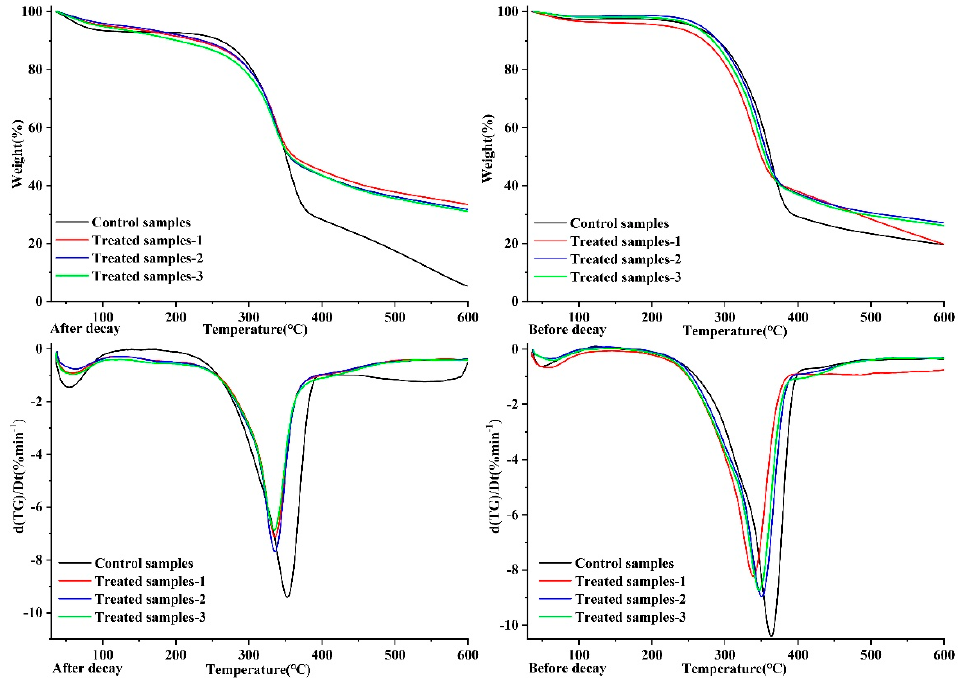
Figure 6. Thermogravimetric (TG)/Differential Thermogravimetric (DTG) spectrum of wood samples before/after decay.